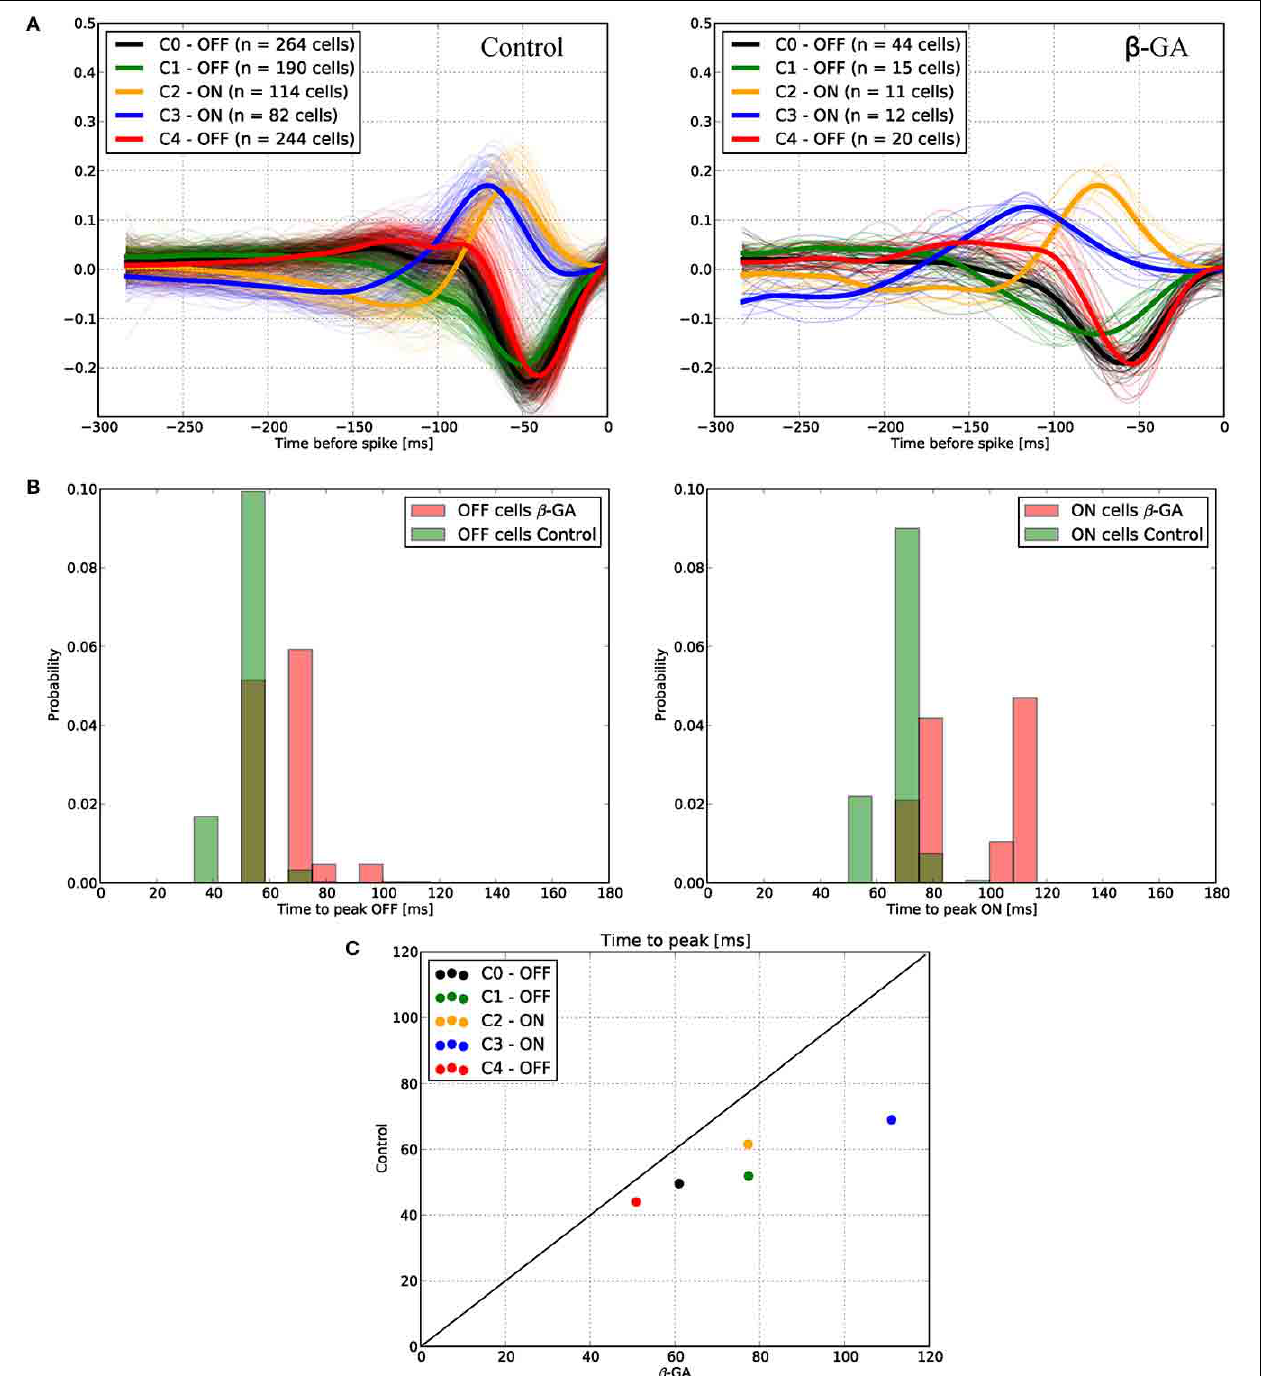
FIGURE 5 | Functional ganglion cell characterization under control and β -GA conditions. Using STA analysis, ganglion cells were classified and clustered into five different groups according to their ON or OFF preference and response timing. (A) The dynamics of the response timing is represented for both control (left) and β -GA conditions (right). β -GA decreased the number of ganglion cells with a valid RF. (B) Distribution of time-to-peak responses under β -GA and control conditions for ON and OFF ganglion cells. Under β -GA treatment, the response latency in the temporal response profile